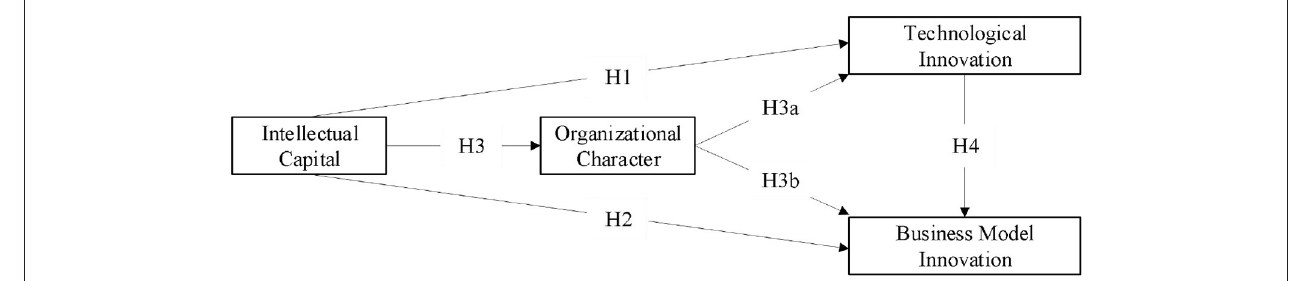
FIGURE 1 | Research